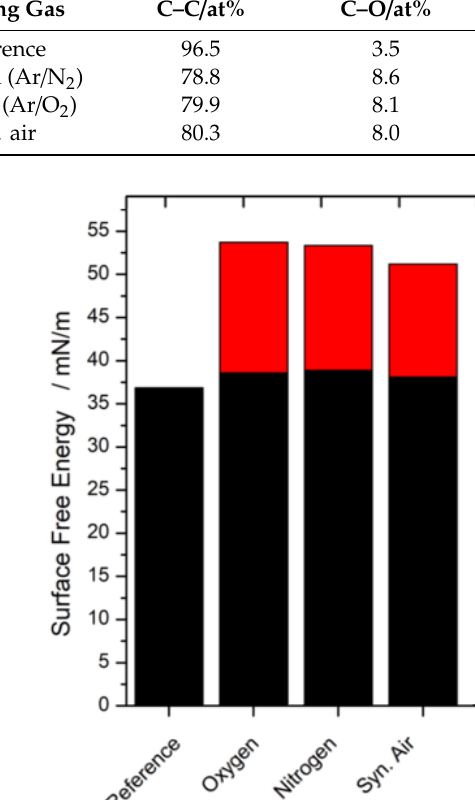
Figure A3. Calculated surface free energy according to the Owens, Wendt, Rabel, and Kaelbe (OWRK) method based on contact angle results of WPC with 60% wood content in PP before and after plasma treatment. For all three working gases, the surface free energy was significantly increased due to a newly formed polar part, due to new functional groups on the surface.